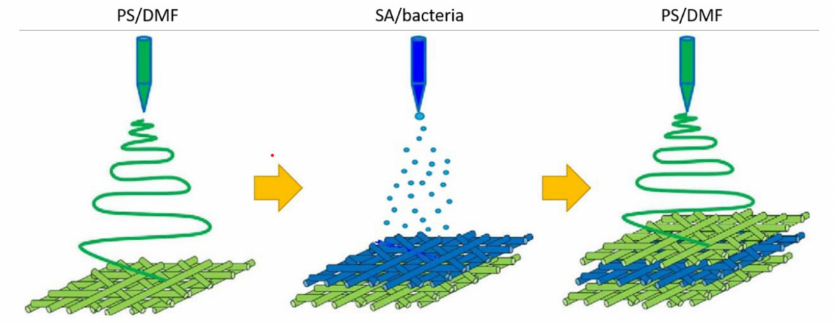
Figure 2. Preparation of alginate hydrogel for the immobilization of bacteria in the layer. Reproduced